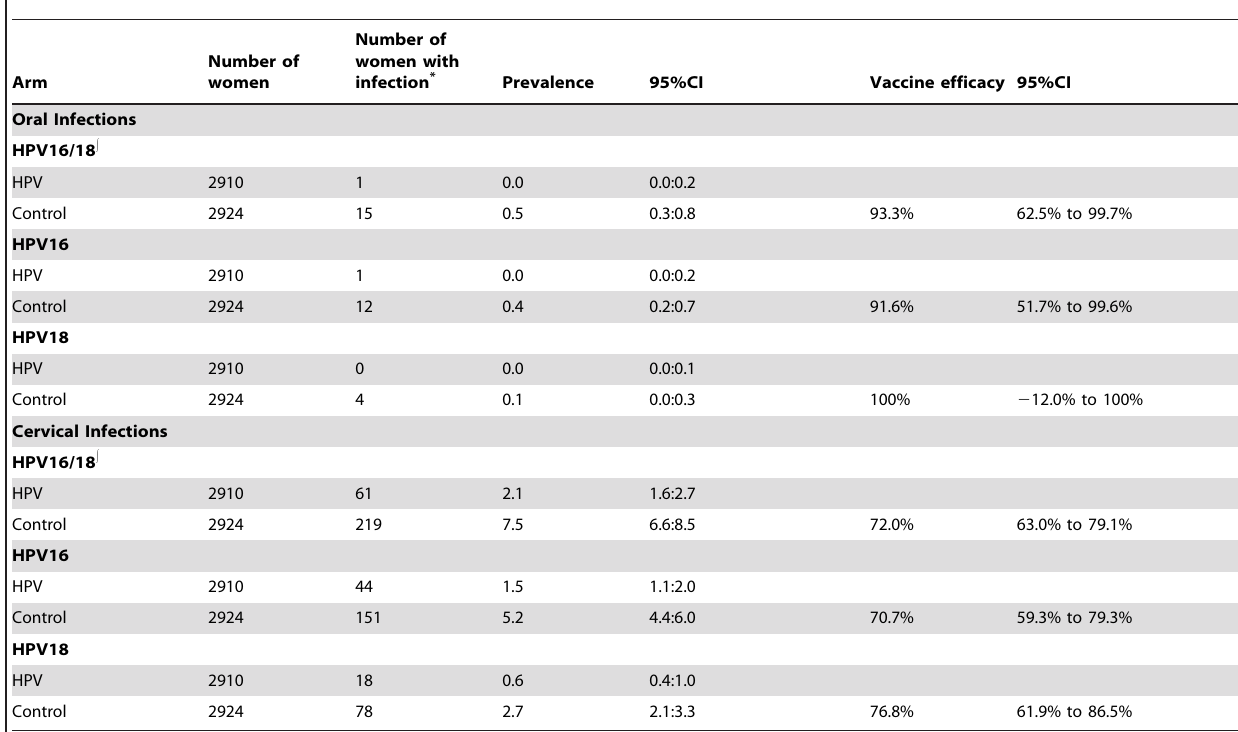
Table 3. Estimated vaccine efficacy against oral and cervical HPV16 and 18 infections 4 years after